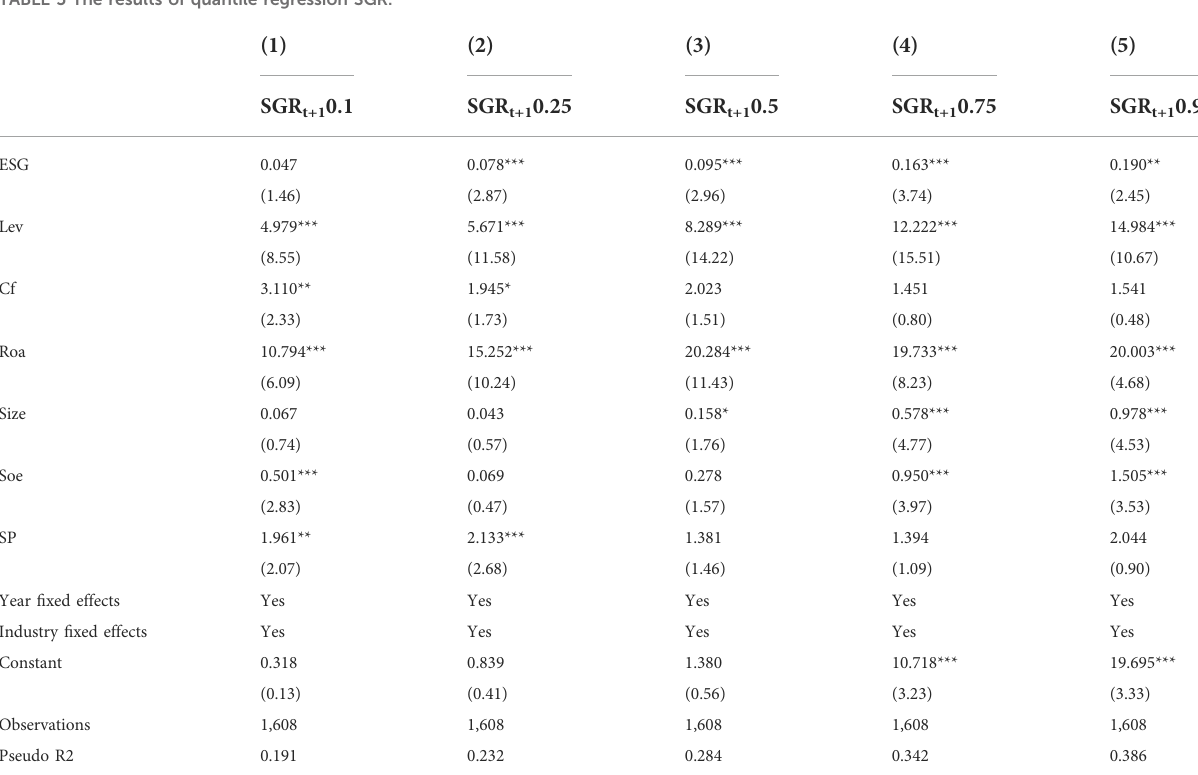
TABLE 5 The results of quantile regression